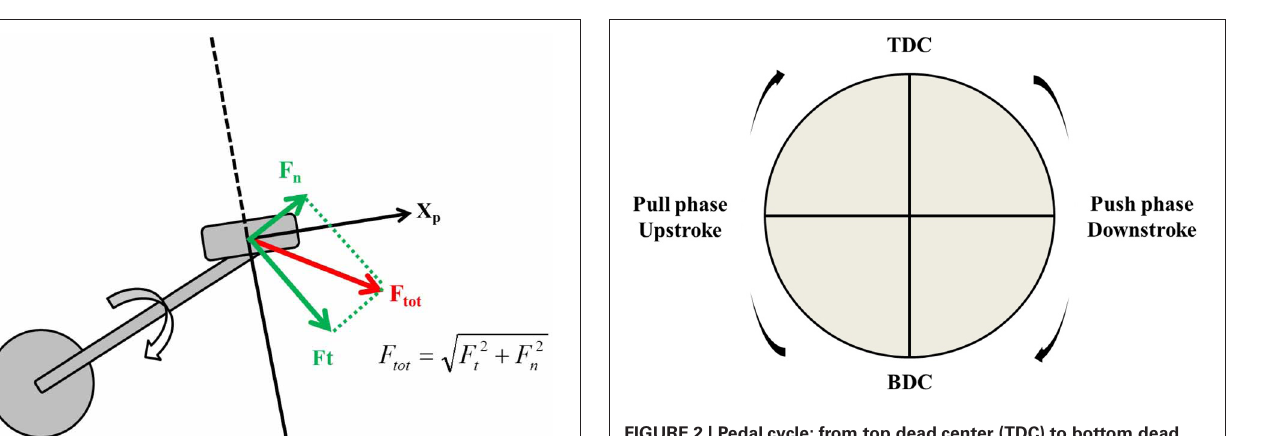
FIGURE 2 | Pedal cycle: from top dead center (TDC) to bottom dead center (BDC) (push phase) and again from BDC to TDC (pull